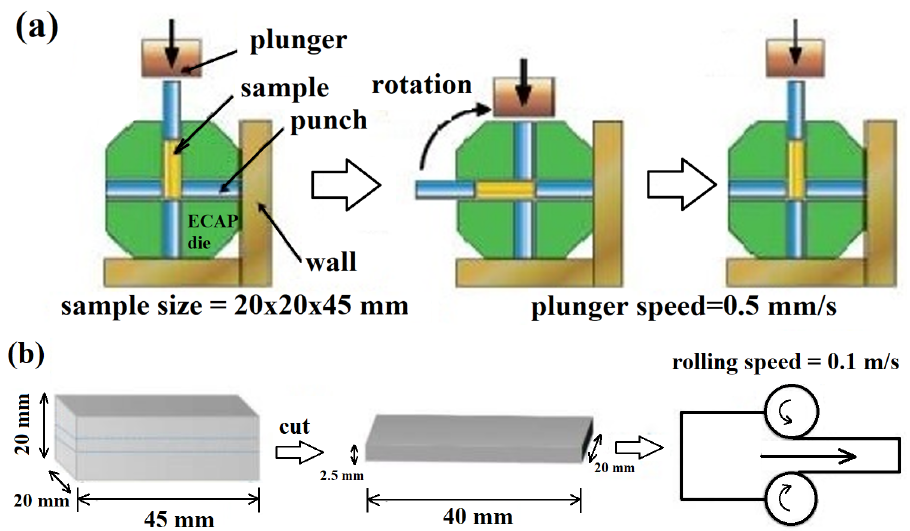
Figure 1. Schematic diagram of ( a ) rotary die equal channel angular pressing (RD-ECAP) process and ( b ) rolling technique